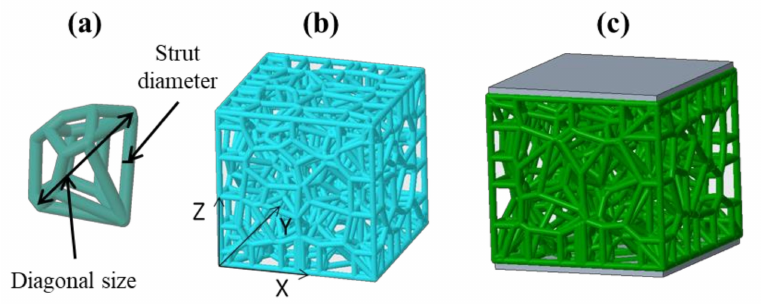
Figure 1. Steps for the architected structure generation: ( a ) basic pattern, ( b ) architected structure, ( c ) addition of plates on the top and bottom faces.